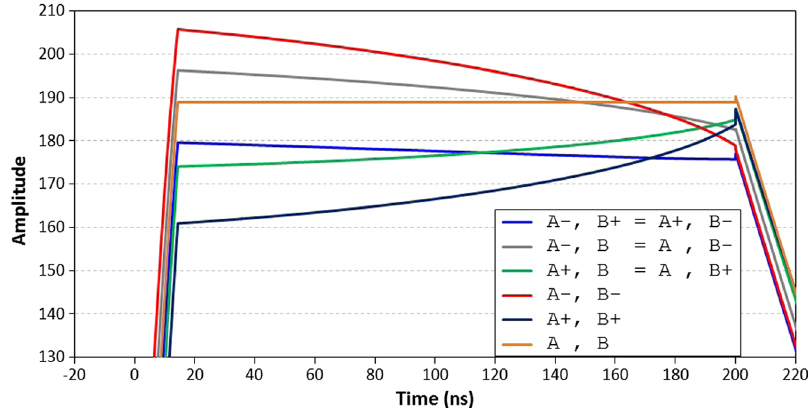
FIG. 11. Simulation of the effect of changing the natural frequency of the pulse compressor cavities. In the key, A þ and B þ means cavities A and B have had their frequency increased by 100 kHz respectively, A − and B − means natural frequencies decreased by 100 kHz and A and B means that natural frequencies stayed the